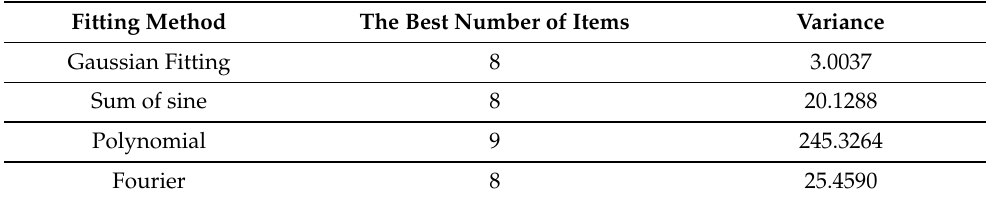
Table 3. The results of different fitting